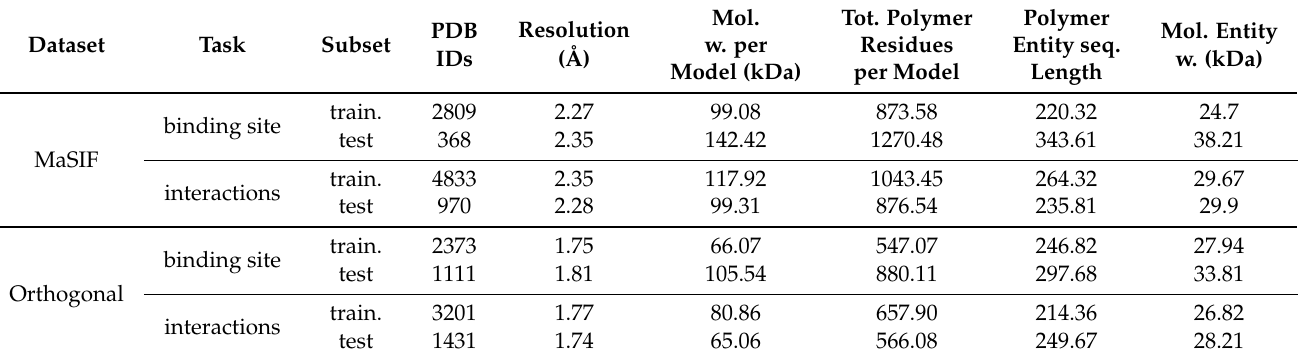
Table 1. Comparison between the MaSIF and Orthogonal datasets. Columns show (from left to right) the dataset name, the considered task (prediction of binding sites or protein–protein interactions), the subset (training or test set), the number of PDB IDs within the datasets, the average resolution of the PDB IDs within the datasets in Å, the average molecular weight per deposited model, the average total number of polymer residues per deposited model, the average polymer entity sequence length, and the average molecular entity